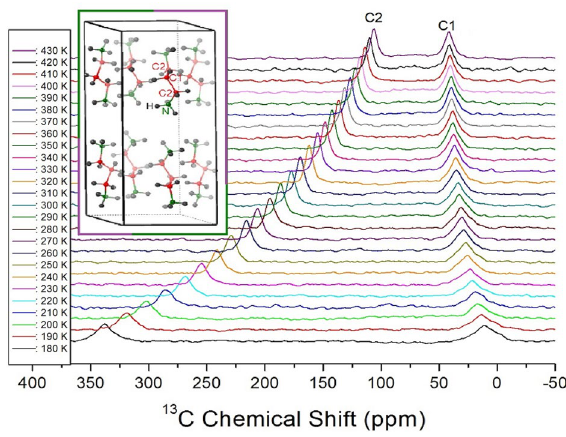
Figure 6. 13 C NMR chemical shifts in [NH 3 (CH 2 ) 3 NH 3 ]CuBr 4 as a function of temperature (Inset: structure of [NH 3 (CH 2 ) 3 NH 3 ]